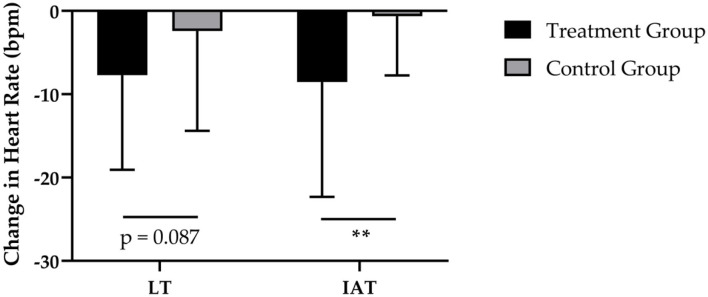
Changes in HR at LT and HR at IAT after 12 weeks of intervention in treatment group (n = 28) and control group (n = 31). Values are means ± SD for n subjects. **Significantly different (p < 0.01) by repeated-measures ANOVA (time × group interaction).